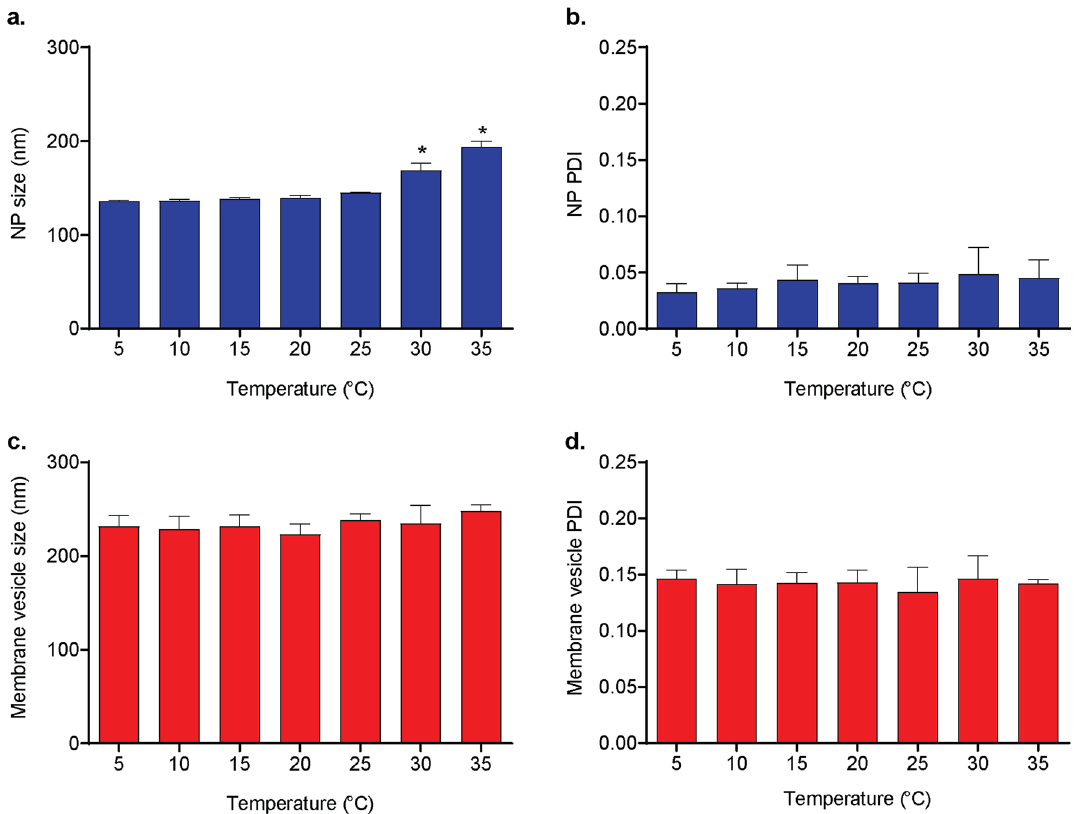
Figure 2. Effect of bath temperature on size and polydispersity of membrane vesicles and PLGA nanoparticles (NPs). ( a ) PLGA NP size (nm), ( b ) PLGA NP polydispersity index (PDI), ( c ) membrane vesicle size, and ( d ) membrane vesicle PDI after sonication at different temperatures for five minutes at 100% amplitude. For all datasets, shown are mean ± SD, n = 3 separate preparations. * p < 0.001 vs. all other temperatures, 1-way ANOVA with Tukey’s post hoc